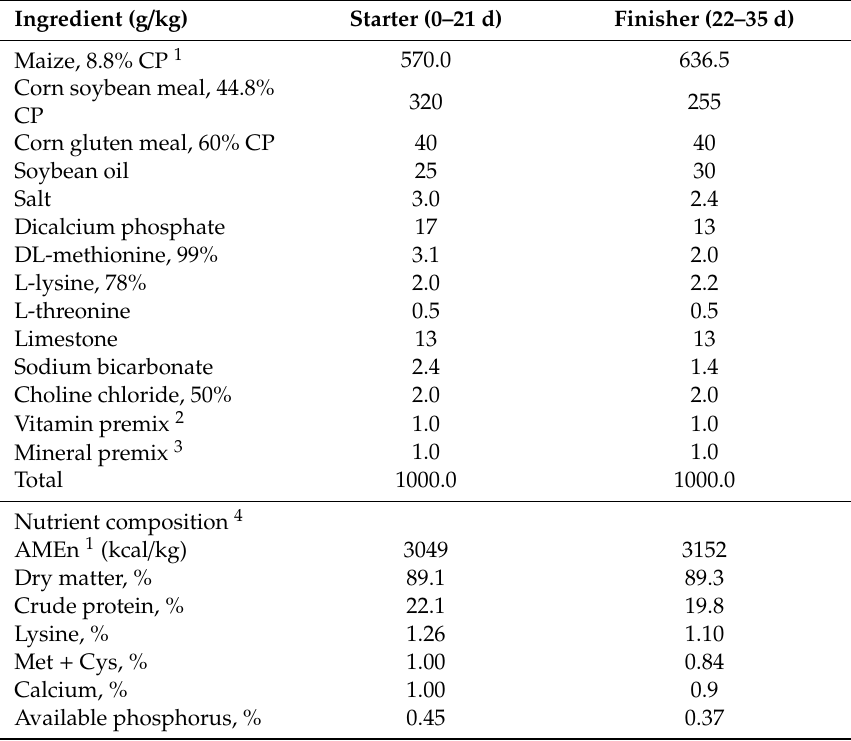
Table 1. Ingredients and composition of the basal diets (as-fed